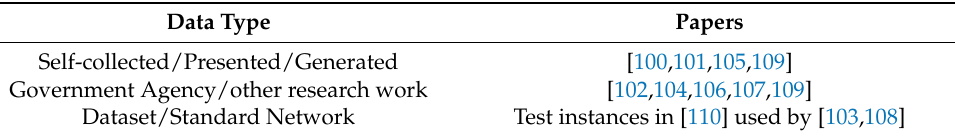
Table 12. Data setup for Smart Industry.